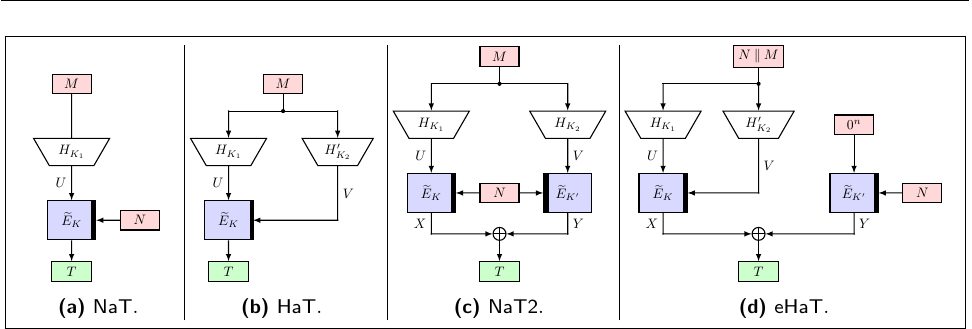
Figure 1: The previous constructions NaT and HaT [CLS17] and our proposals NaT2 and eHaT .